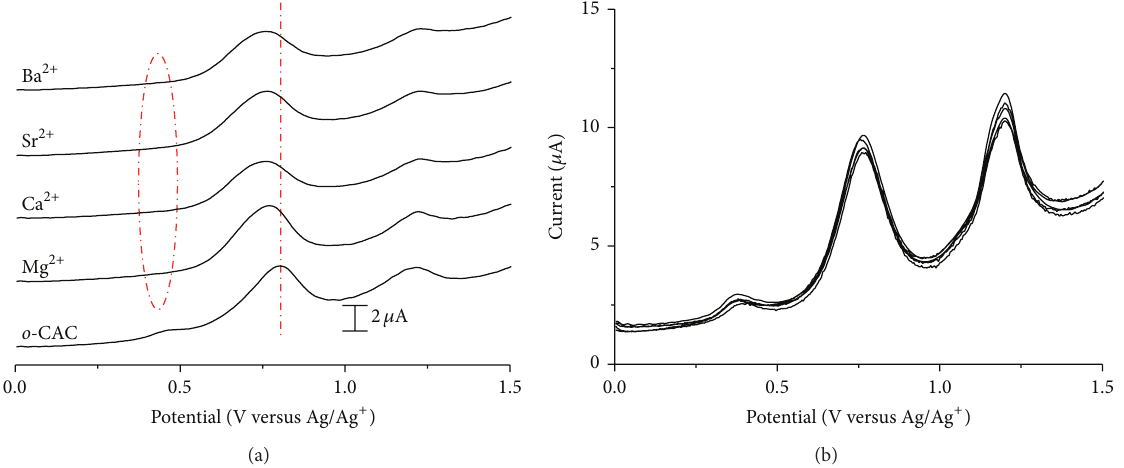
Figure 3: DPVs of (a) o -CAC and (b) o -EAC (1 × 10 −4 M) in the absence and presence of alkaline earth metal ions (1 × 10 −4 M).